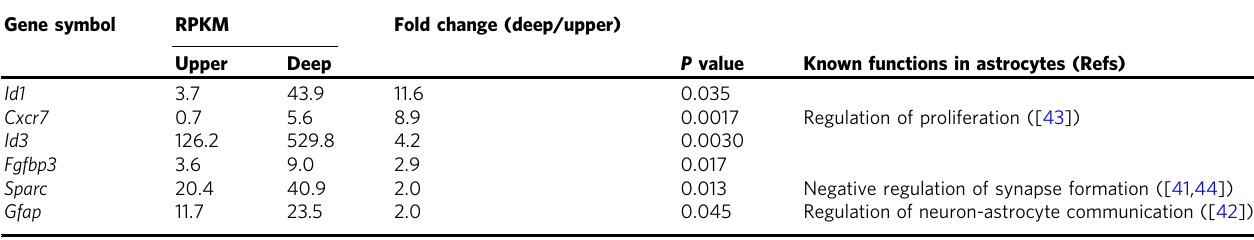
Table 2 Deep-layer enriched astrocytic genes Gene symbol RPKM Fold change (deep/upper) Upper Deep P value Known functions in astrocytes